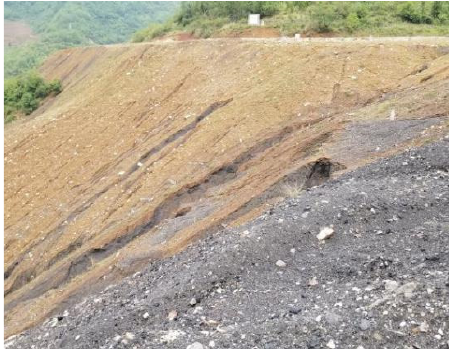
Figure 3. Gully no. 5.